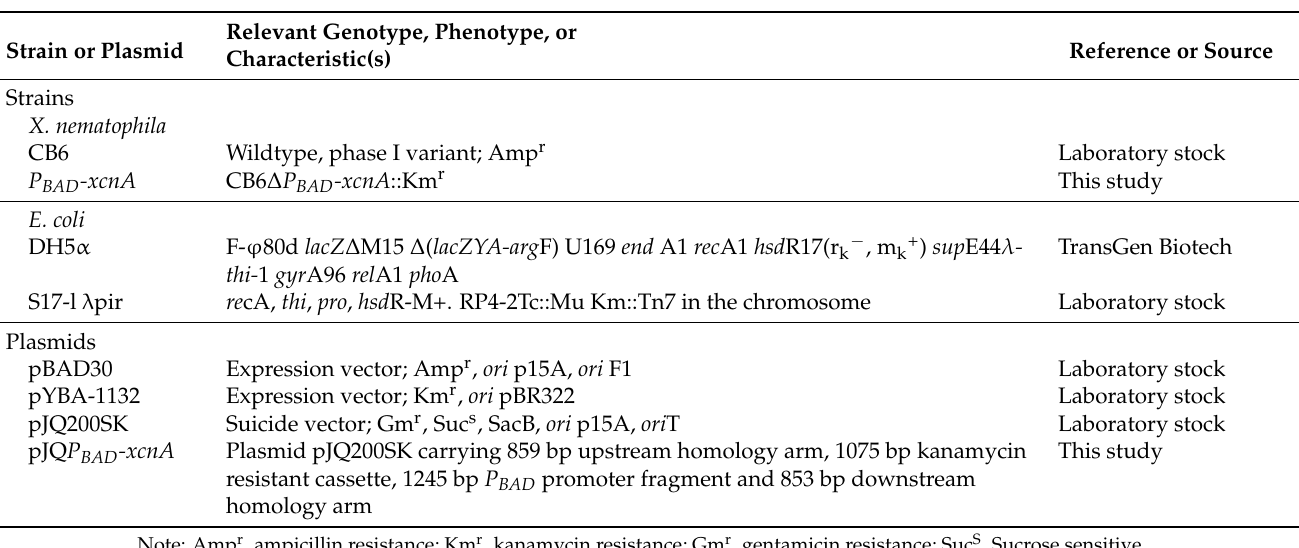
Table 1. Bacterial strains and plasmids used in this